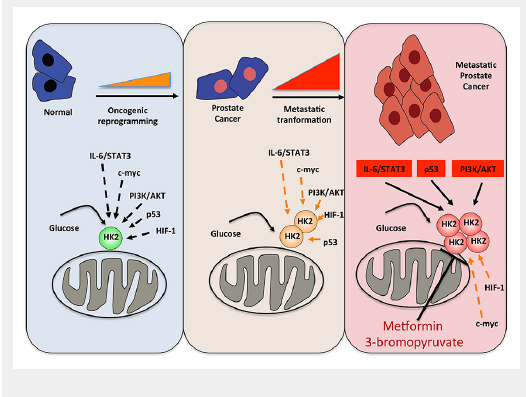
Targeting IL-6/STAT3-p53-PI3K/AKT signalling inducing metastatic prostate cancer metabolism by HK2 inhibitors (metformin or